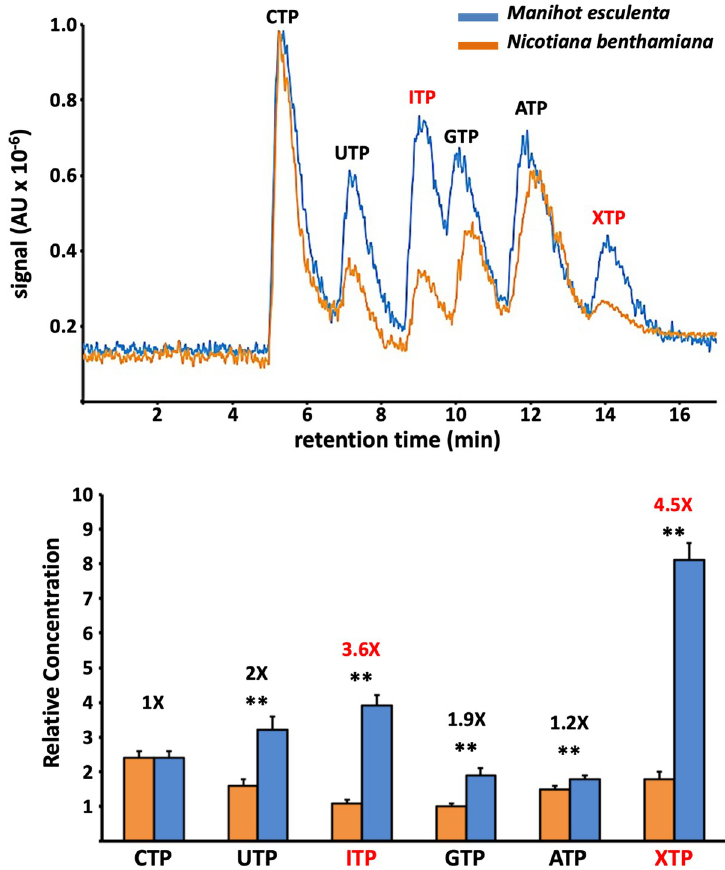
Fig 5. High accumulation of non-canonical nucleotides in cassava. Upper panel: base peak chromatogram in arbitrary units (AU) for representative samples of total NTPs from Manihot esculenta (blue) and Nicotiana benthamiana (orange) analysed accordingly to the method described in the text. Lower panel: Bar graph that represents averaged concentrations (n = 12; for normalization, GTP in N . benthamiana = 1). The original data set showing relative concentrations is presented in S5 Table. Statistical differences were tested with the post-hoc Tukey HDS test ( �� p < 0.01). Ratios ( M . esculenta/N . benthamiana ) for each NTP are also indicated. Non-canonical nucleotides are highlighted in